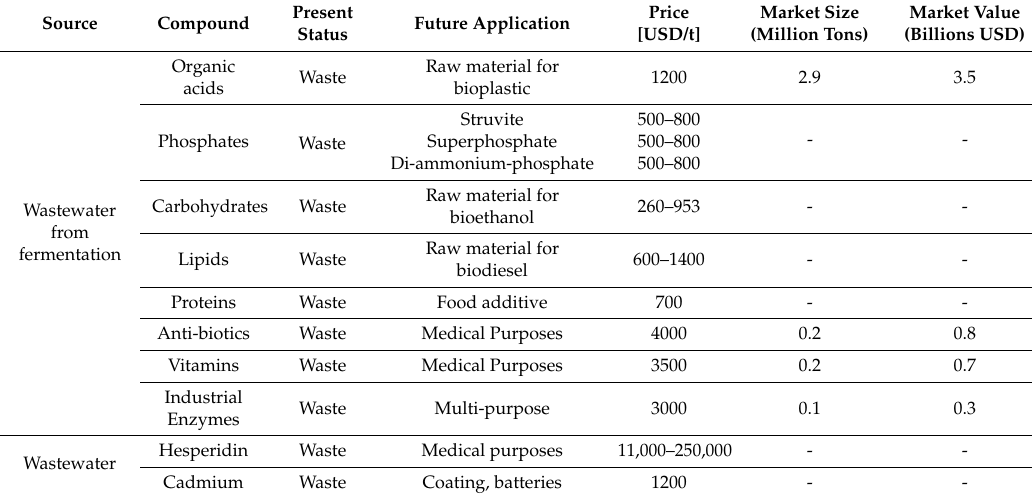
Table 1. Potentially valuable products present in wastewater streams and waste from fermentation processes, with their present status and potential future application, with estimated product